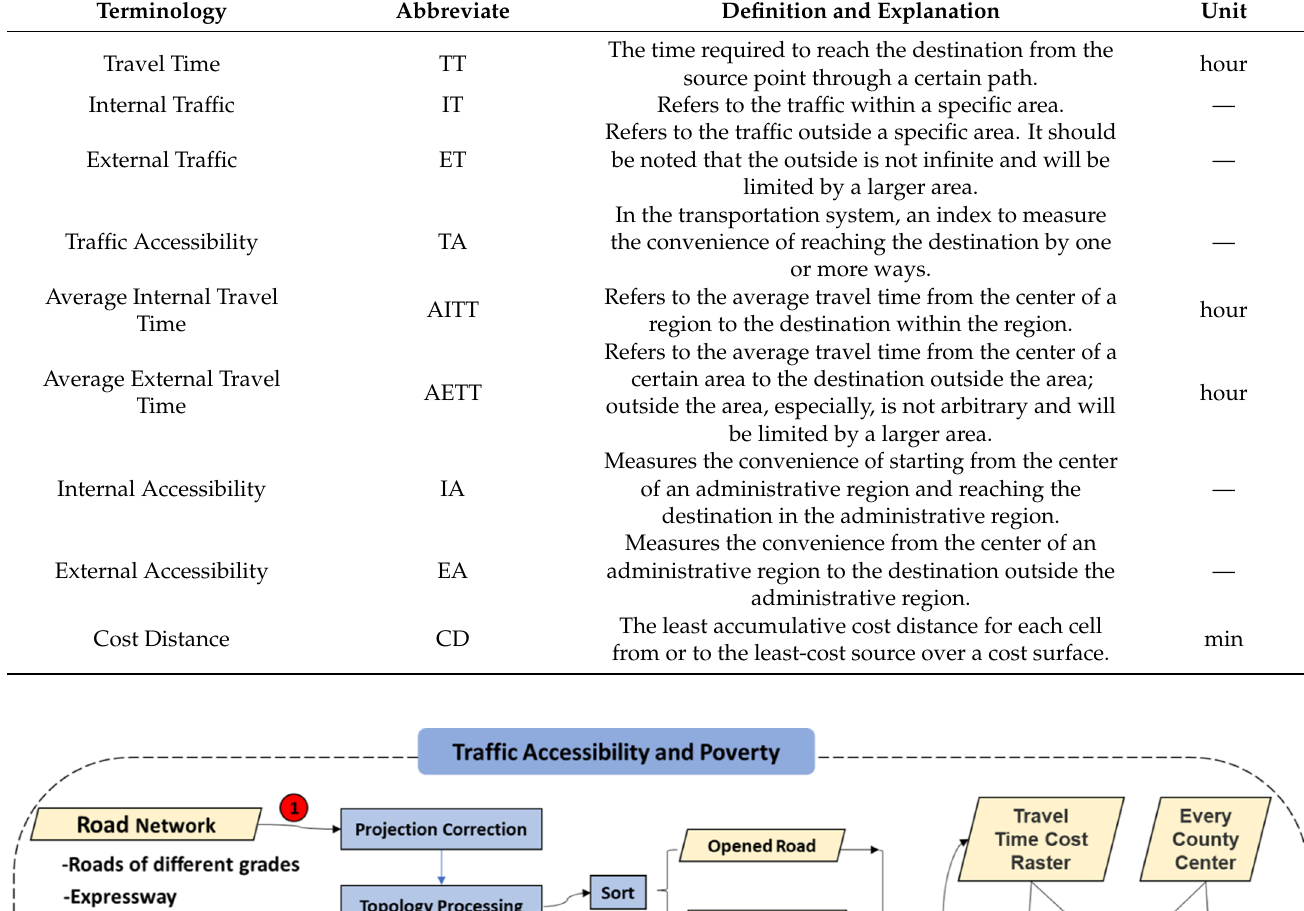
Table 2. Introduction of basic traffic terminology in this study.